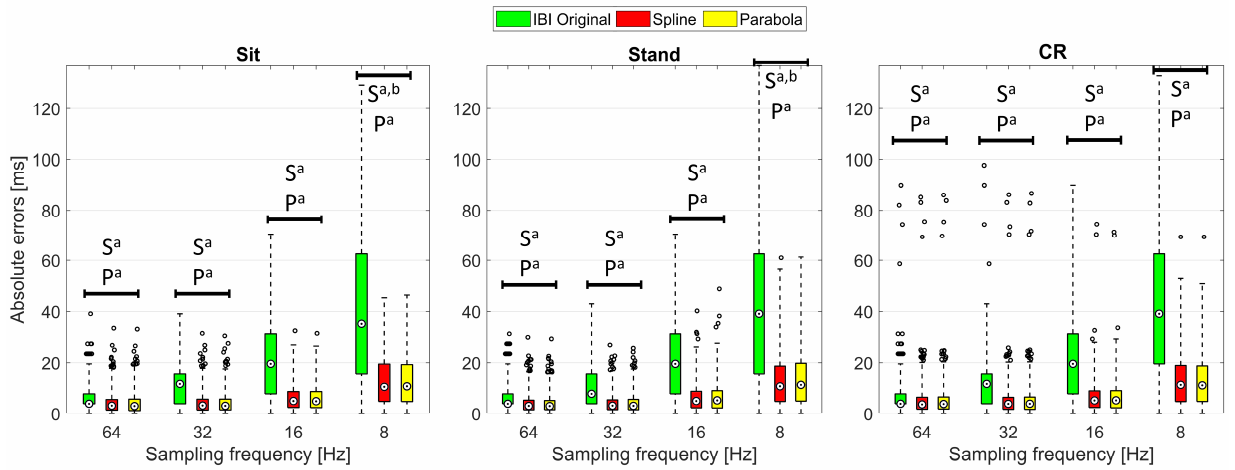
Figure 5. Boxplots of the beat-to-beat AEs computed with the original IBIs and with those obtained through SPLINE and PARABOLA interpolations. Significant differences (Bonferroni-corrected comparisons, p < 0.05) are highlighted between AEs within each sampling frequency and protocol condition. a: AEs related to SPLINE (S) or PARABOLA (P) are significantly different from the original; b: AEs related to SPLINE (S) are significantly different from PARABOLA.